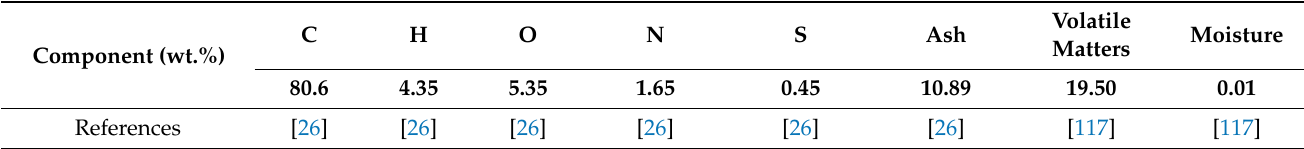
Table 5. Selected parameters of conventional pulverized coal [26,117].